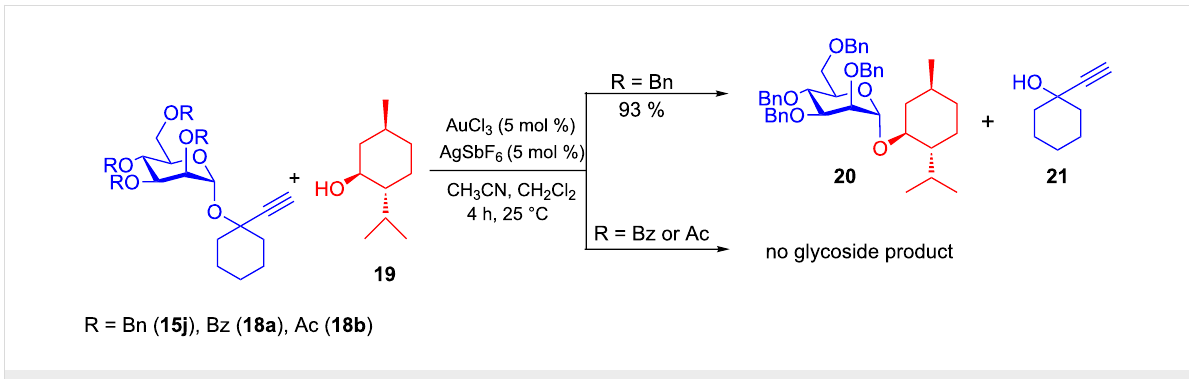
Scheme 4: Armed–disarmed effect in Ech-glycosides during gold-catalyzed